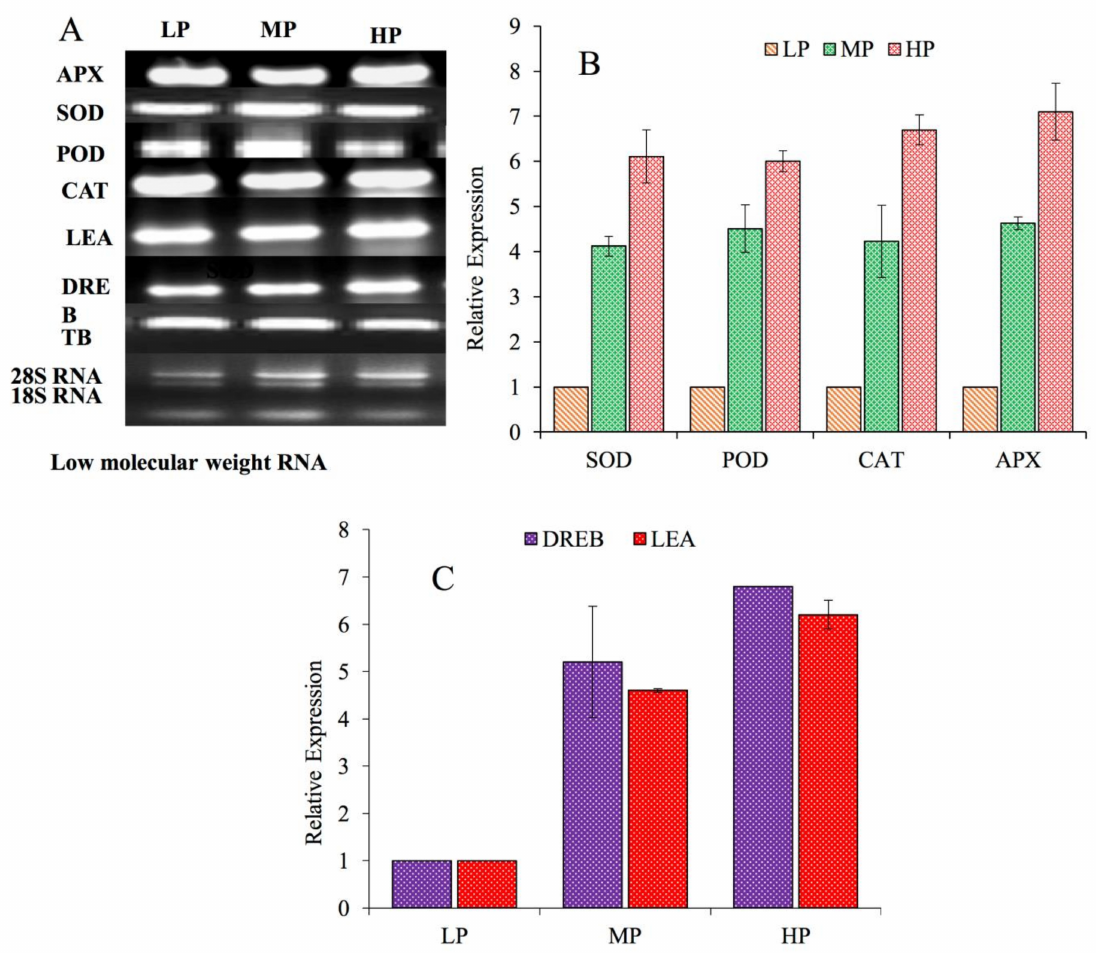
Figure 4. Transcriptional expression of antioxidant and stress related genes in P. dulce under fly ash stress. ( A ) Semi quantitative PCR showing expression. ( B & C ) Relative gene expression of antioxidant and stress related genes through Real time